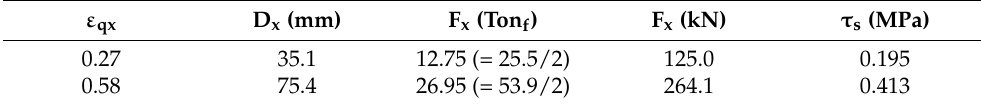
Figure 4. Mean shear force-displacement graph of elastomeric bearing specimen measured through the experiment. The thickness of elastomer in this specimen (T q ) is 130 mm. Table 2. Shear modulus test conditions.